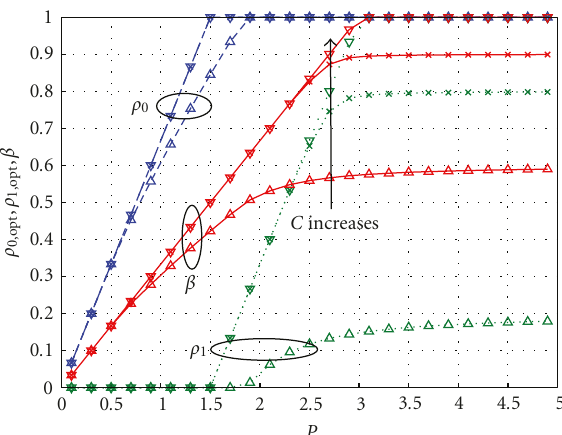
Figure 12: The optimal ρ 0 , ρ 1 , β under policy π 2 for di ff erent C.